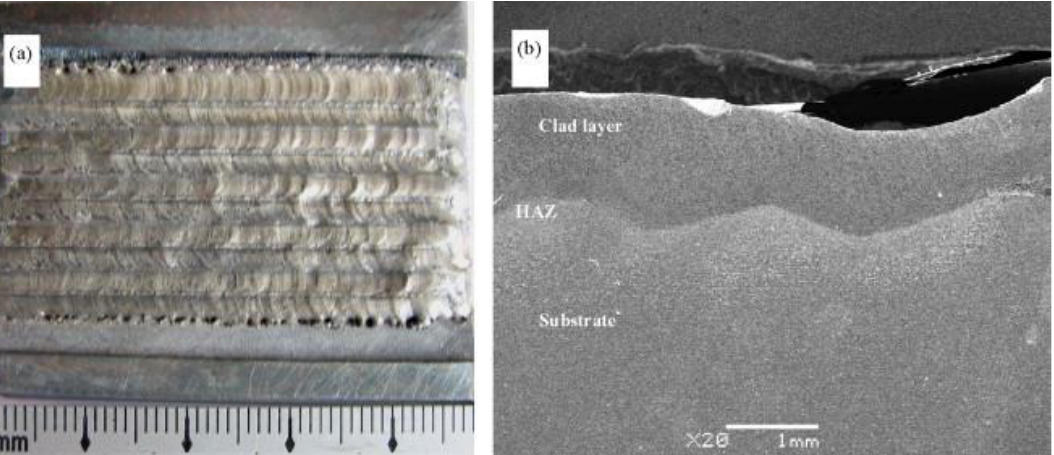
Figure 5. Macrograph of LC of TiB2/Fe composite coating on AISI 1010 steel: ( a ) top surface, ( b ) cross-section showing clad layer, HAZ, and substrate. Reproduced with permission from [59].